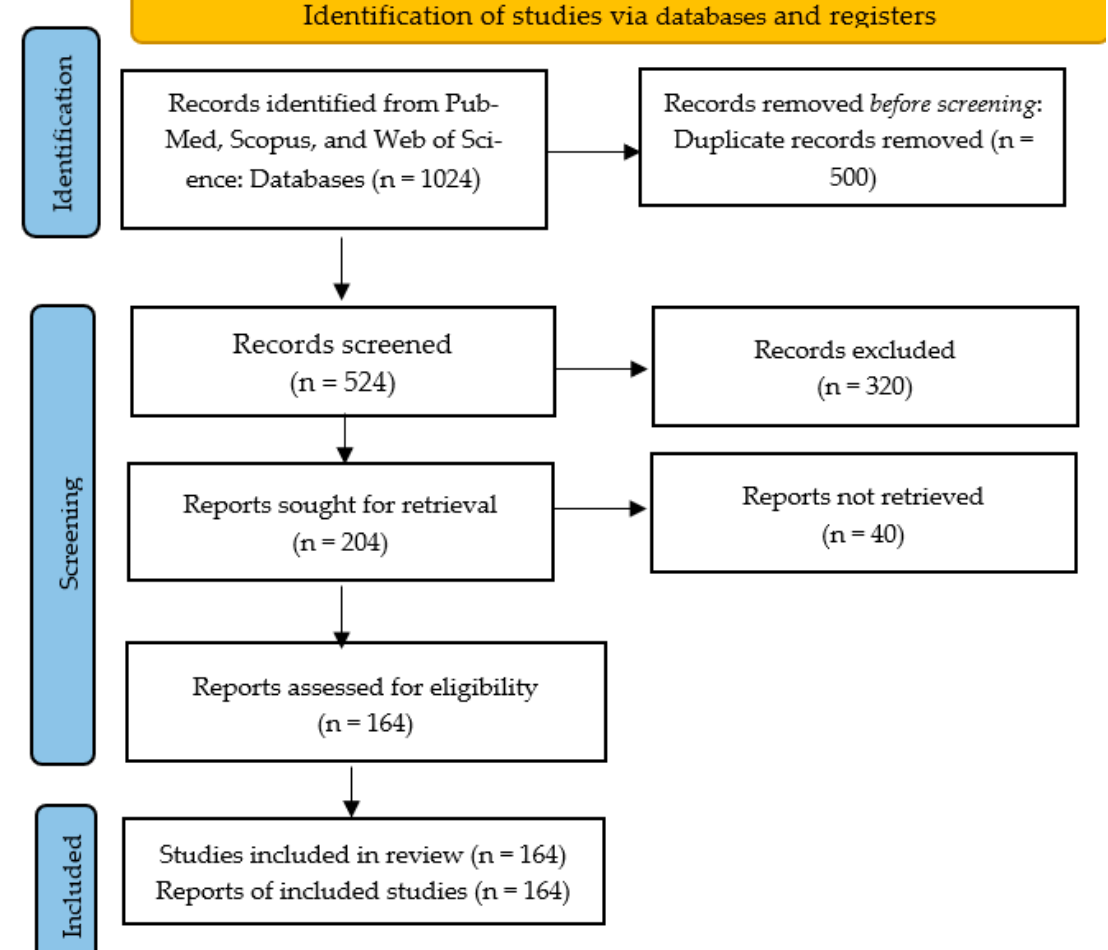
Figure 1. PRISMA review process for selection of records from research databases.